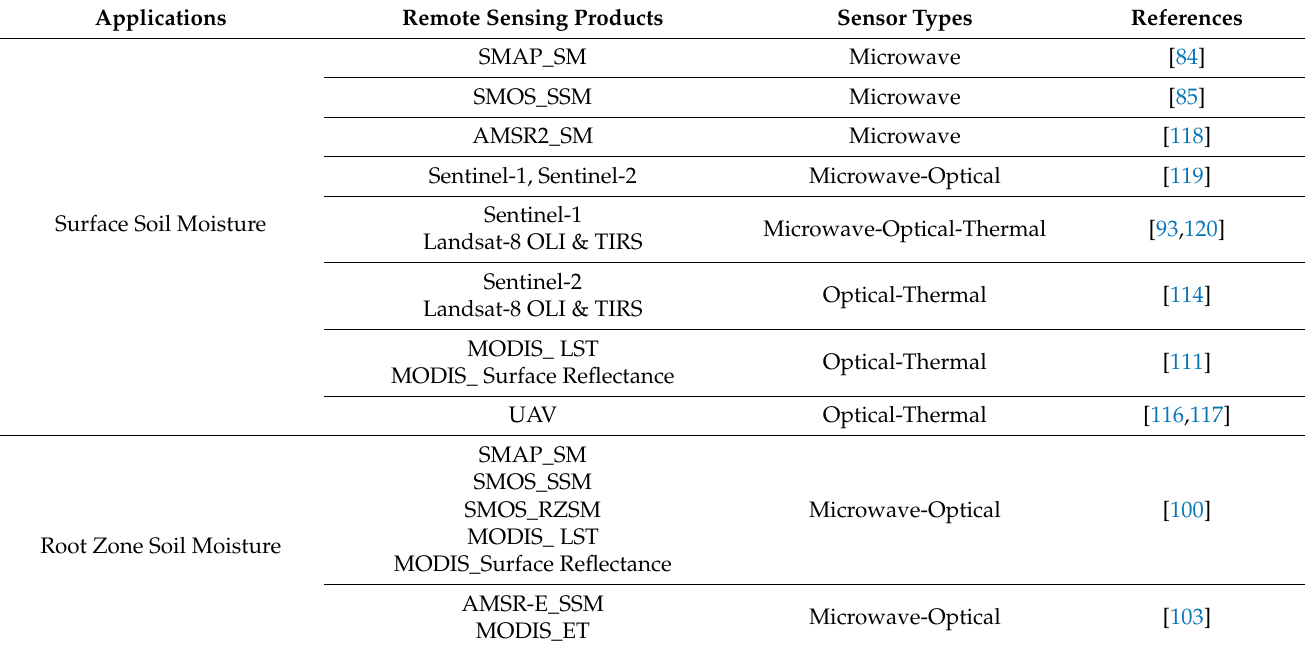
Table 2. Overview of numerous remote sensing products and sensor types for the estimation of SSM and